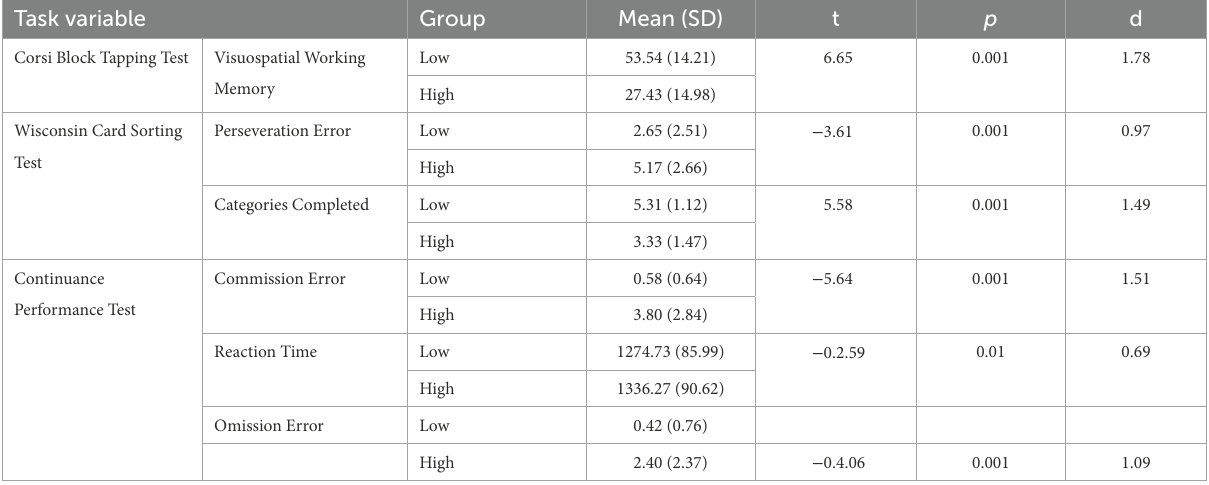
TABLE 1 Descriptive statistics and comparison of the groups based EFs variables. Task